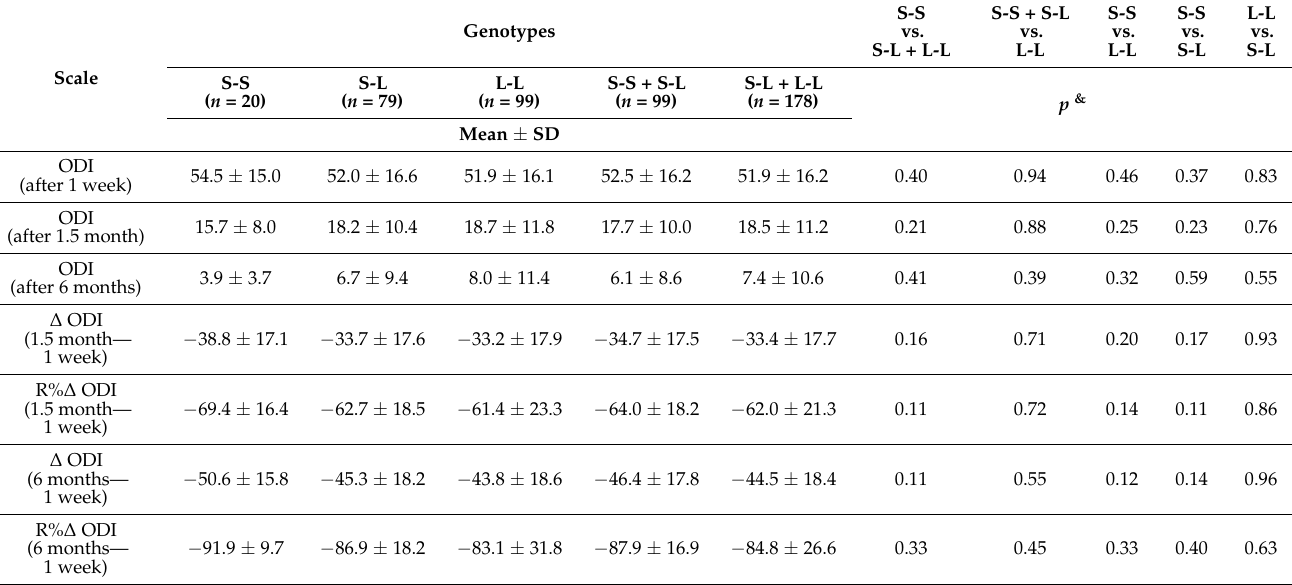
Table 8. Association of CNR1 genotype with patients’ degree of disability at defined intervals.